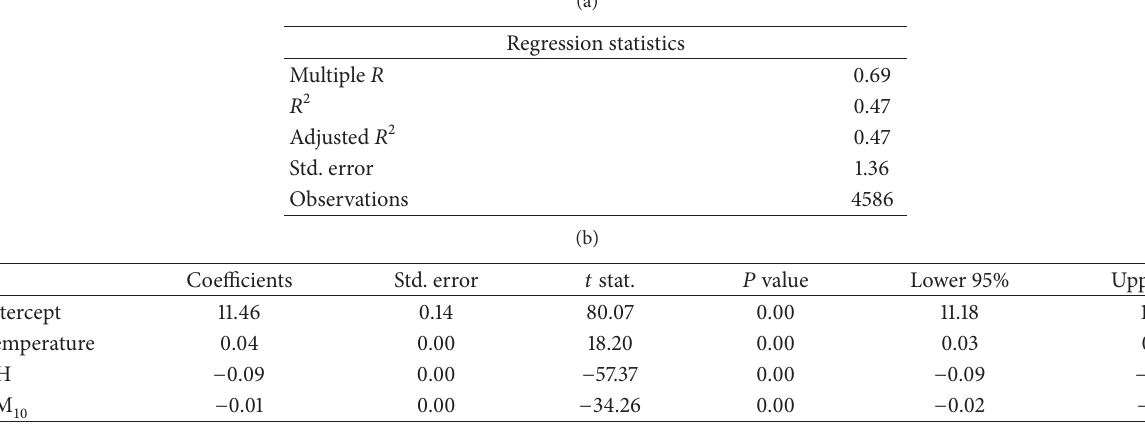
Table 2: Multiple regression statistics for visibility to temperature, relative humidity, and PM 10